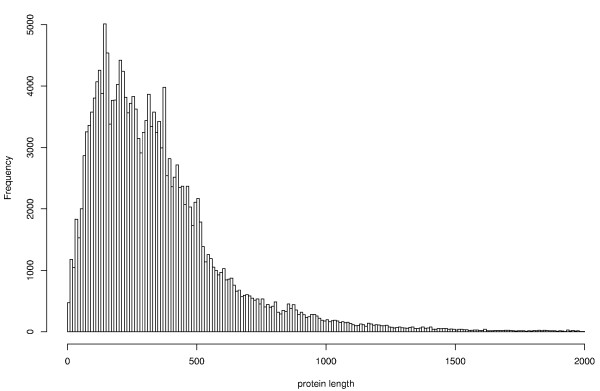
Empiric distribution of Swissprot (release 47.8) protein lengths. In order to improve readability, 0.5% of sequences with length ∈ [2 000, 9 000] have been removed from this histogram.